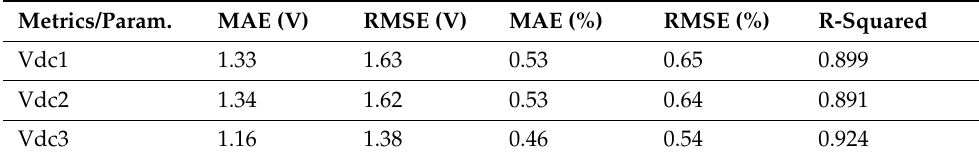
notice that the simulation results of DC power are very close to those of DC current.